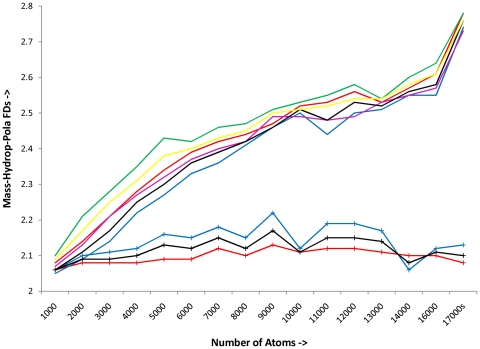
Distribution of MFD, HFD and PFD for thermophilic and mesophilic proteins.Mean magnitudes of MFD, HFD and PFD for each group of proteins (segregated by their number of atoms) are plotted. ([+(HFD-MFD]) provides an unambiguous measure of ‘untapped-hydrophobicity’, it assumes greater magnitude for thermophilic proteins(across SCOP classes) than the mesophilic proteins. Legends:
Red solid line (—) : Distribution of Thermophilic Mass-FDGreen solid line (—) : Distribution of Thermophilic Hydrophobic-FDRed (+—+) pattern : Distribution of Thermophilic Polarizability-FDBlue solid line (—) : Distribution of Mesophilic Mass-FDPink solid line (—) : Distribution of Mesophilic Hydrophobic-FDBlue (+—+) pattern : Distribution of Mesophilic Polarizability-FDBlack solid line (—) : Distribution of Mass-FD of the entire protein set.Yellow solid line (—) : Distribution of Hydrophobic-FD of the entire protein set.Black (+—+) pattern : Distribution of Polarizability-FD of the entire protein set.
Please consult the Supplementary Mat S3 for complete information regarding this diagram.